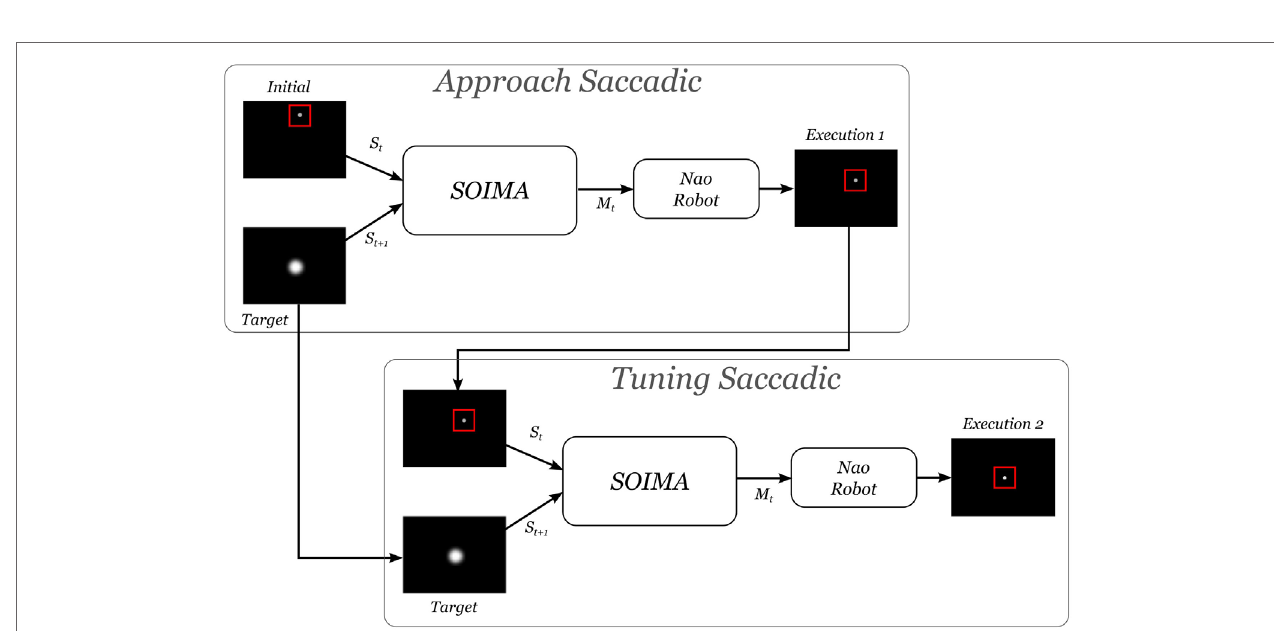
FigUre 10 | execution algorithm for saccadic movements . See text for explanation.